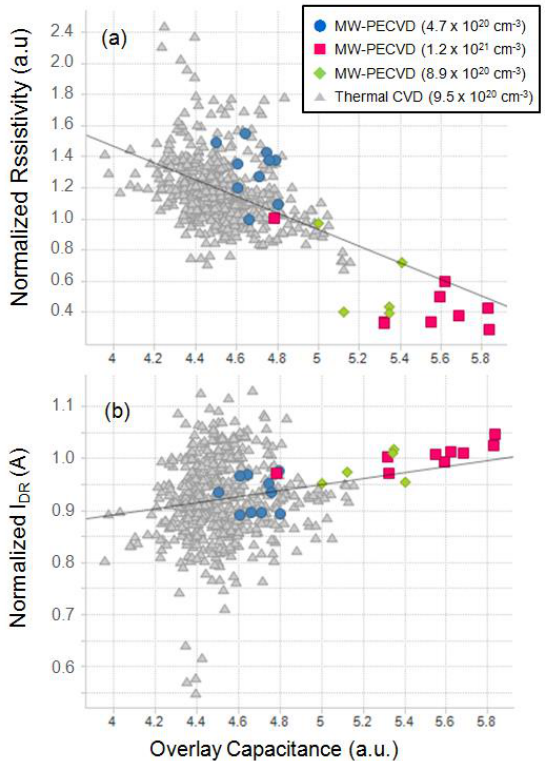
Figure 7. ( a ) The gBC resistivity ( R C ) and ( b ) on-current ( I DR ) of the 20 nm pitch DRAM (Dynamic Random Access Memory) device with various MW-CVD growth conditions.